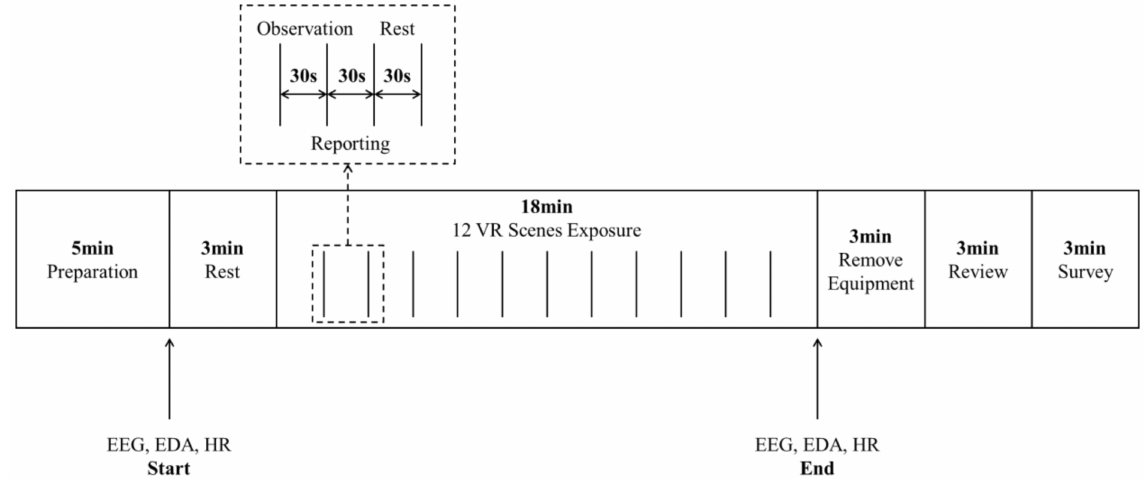
Figure 4. Experiment